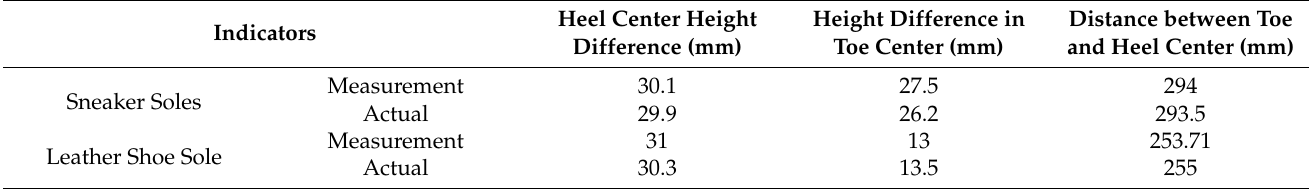
Table 4. Comparison table of reconstruction accuracy of different